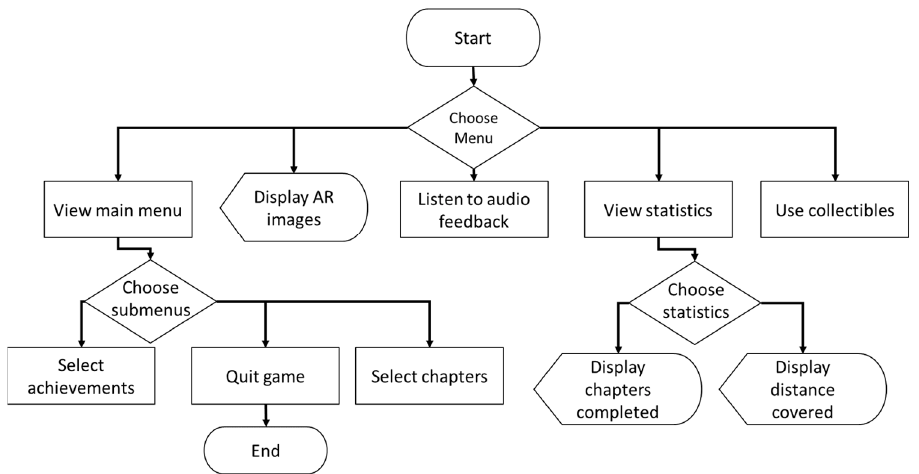
Figure 19. Flowchart of the Endure